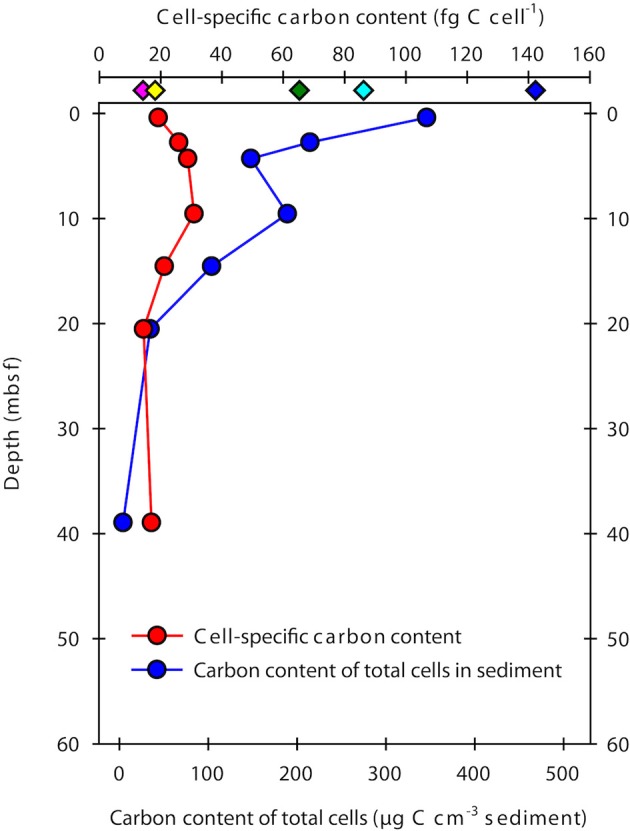
Cell-specific carbon content and total microbial cell carbon in samples from Landsort Deep. The cell-specific carbon content (red symbols) was determined from direct measurements of cellular amino acids, assuming these comprise ~55% of total cell carbon (Ingraham et al., 1983). Diamond symbols at the top indicate previously estimated cellular carbon contents for sub-seafloor cells (green, Parkes et al., 1994; cyan, Whitman et al., 1998; yellow, Lipp et al., 2008; pink, Kallmeyer et al., 2012) and for FACS-purified E. coli cells (blue, Braun et al., 2016). The carbon content of total microbial cells in the sediment (blue circle symbols) was obtained by multiplying the mean cell-specific carbon content with the number of DNA stainable microbial cells (Andrén et al., 2015).